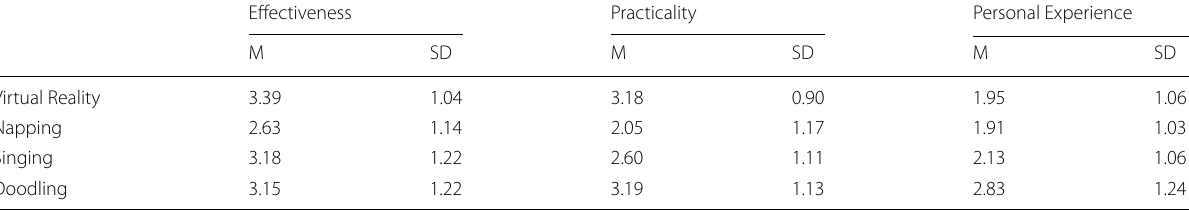
Table 3 Descriptive statistics for baseline beliefs about interventions for pretest to Experiment 2